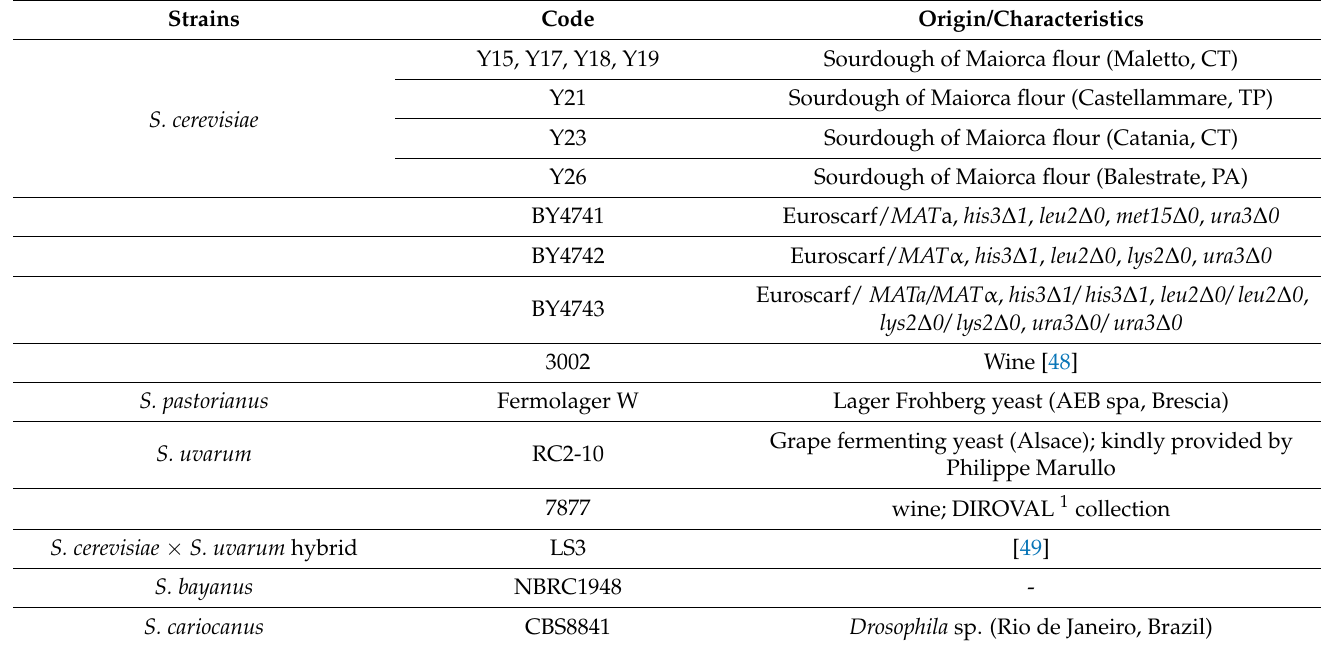
Table 1. Strains used in this